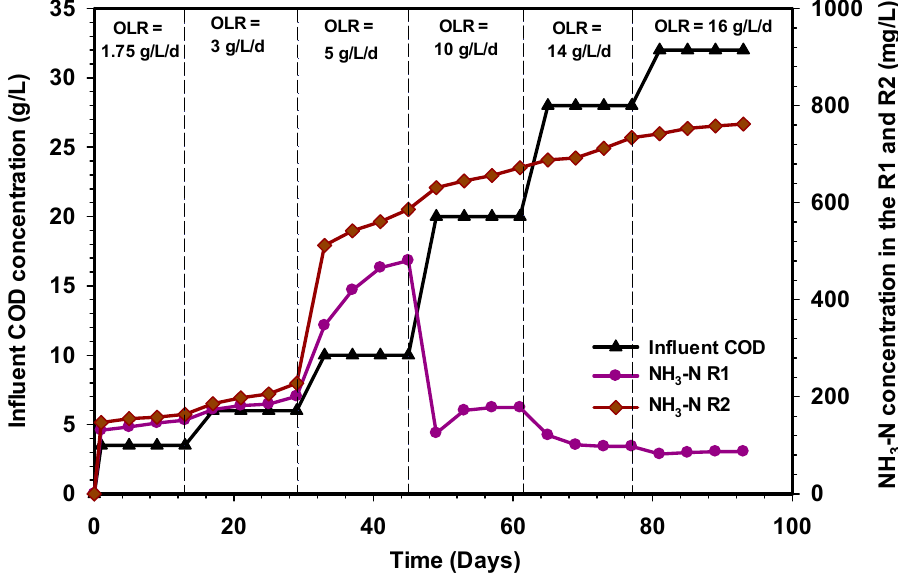
Figure 6. Variation of ammonia nitrogen concentration (NH 3 -N) in R1 and R2 reactors.